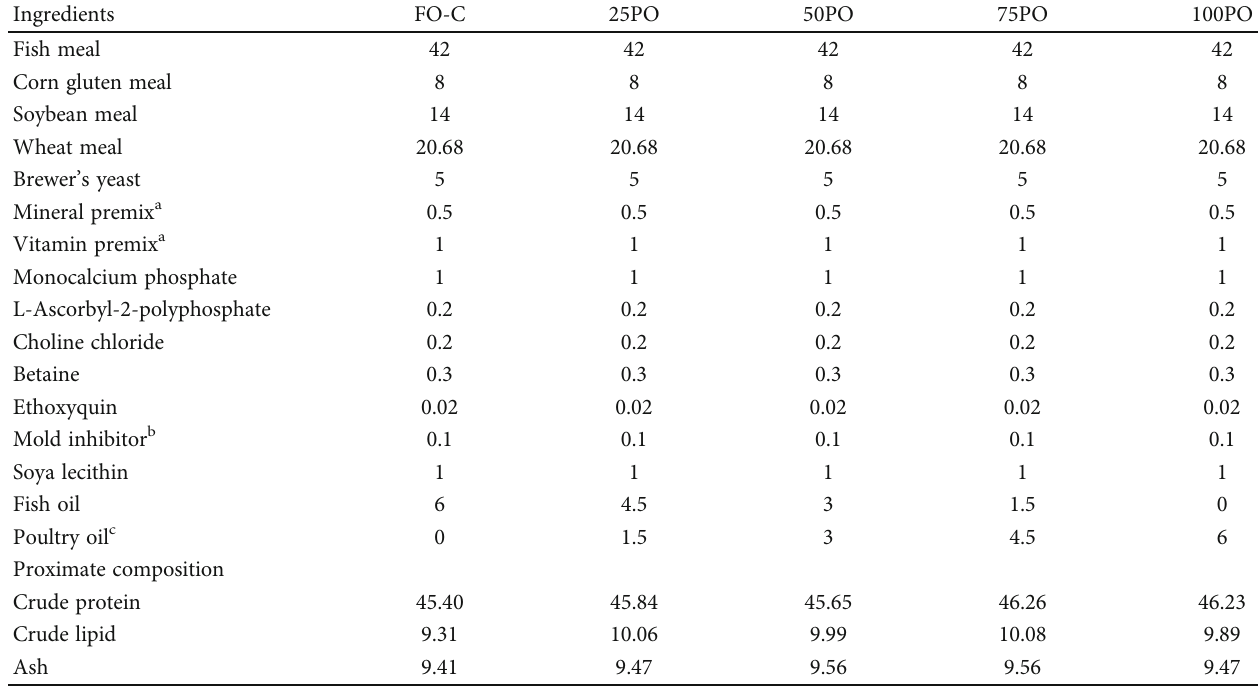
Table 1: Formulation and proximate composition of the experimental diets (% dry matter